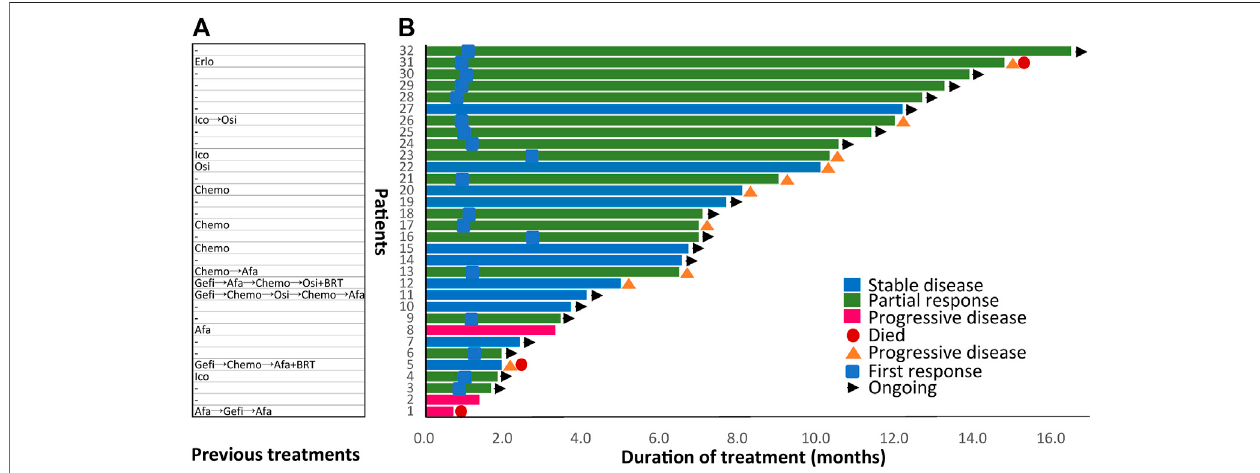
FIGURE 2 | Previous treatments before dacomitinib initiation and duration of dacomitinib treatment by patient ( N = 32). (A) Treatment history of each patient was displayed. (B) Duration of dacomitinib treatment of each patient was demonstrated correspondingly. Afa, afatinib; Ge fi , ge fi tinib; Erlo, erlotinib; Ico, icotinib; Osi, osimertinib; Chemo, chemotherapy; BRT, whole brain